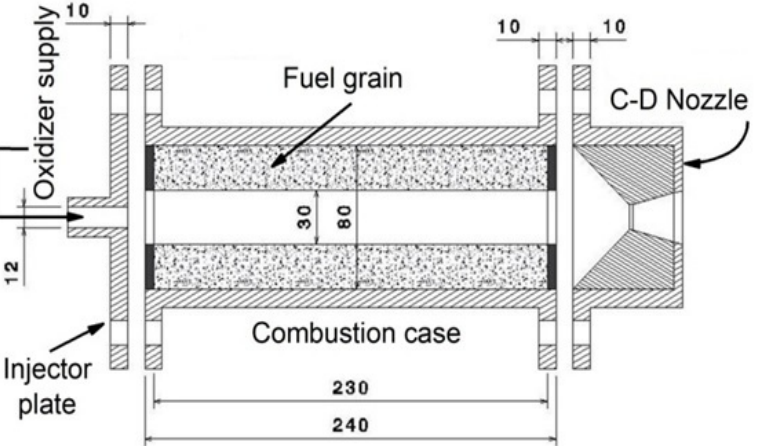
Figure 3. Schematic diagram of hybrid rocket motor (all dimensions in mm).